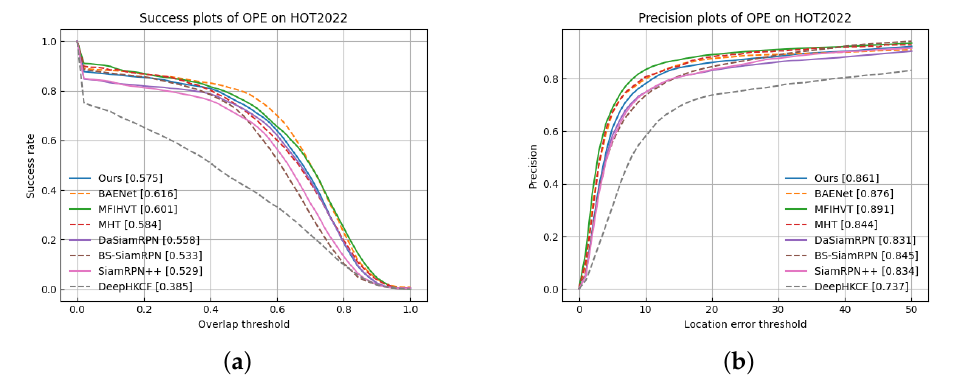
Figure 16. Success rate and precision rate referring to overall sequences. ( a ) Success plots; ( b ) Preci- sion